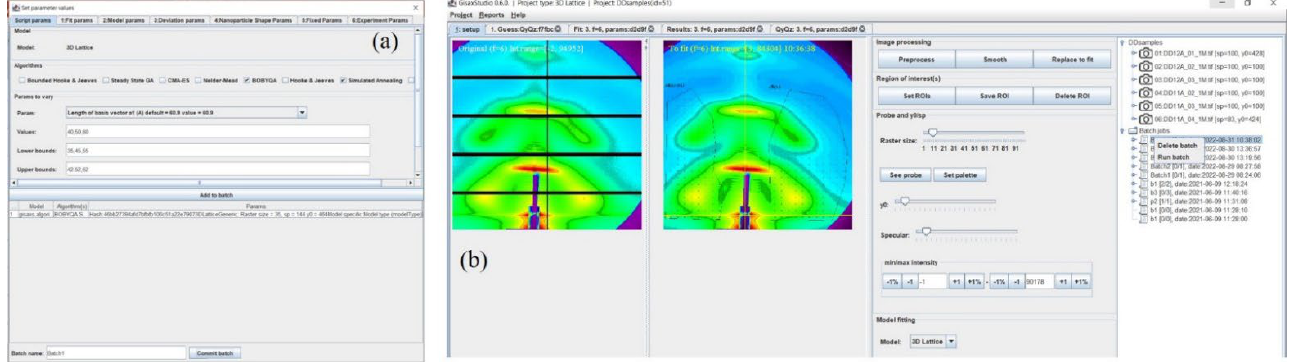
Figure 10. ( a ) Tab related to Batch fit option. ( b ) Start or delete options of Batch fit in the main window.